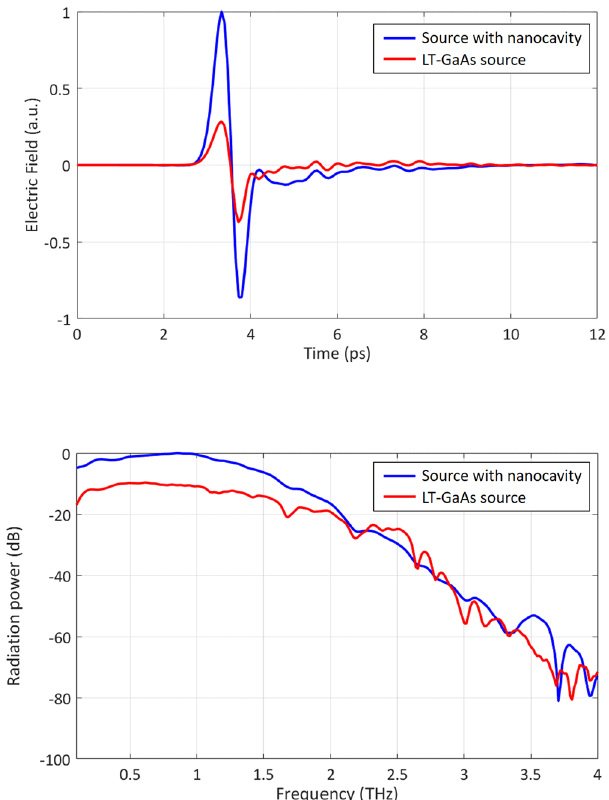
Figure 7. ( a ) The radiated electric fields and ( b ) the corresponding radiated power spectra of the nanocavity- based terahertz source and the terahertz source fabricated on the LT-GaAs